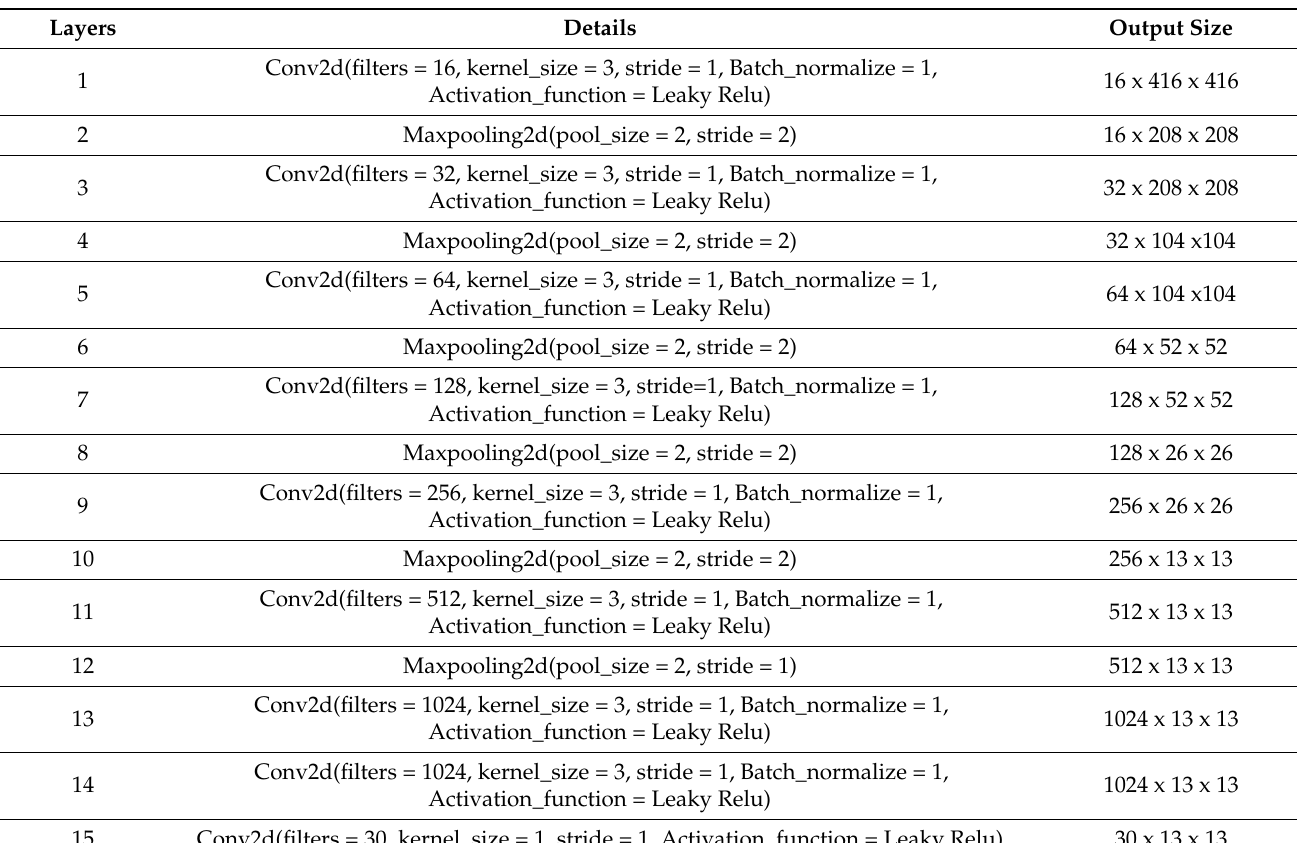
Table 1. The parameters of tiny-YOLO-VOC